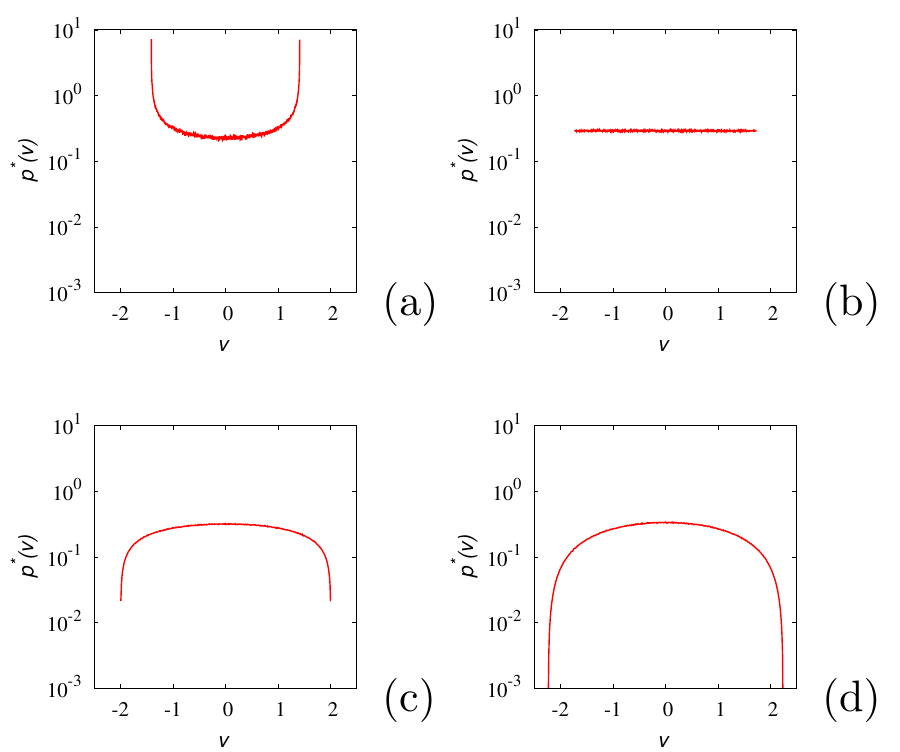
Figure 7. p ∗ ( v ) vs. v at different values of n obtained from Monte Carlo simulations. Panel ( a ): n = 2, panel ( b ): n = 3, panel ( c ): n = 4, panel ( d ) n = 5.